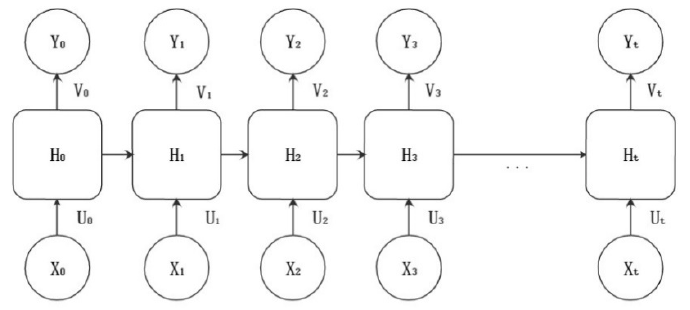
Figure 3. Unfolded structure of a simple RNN.